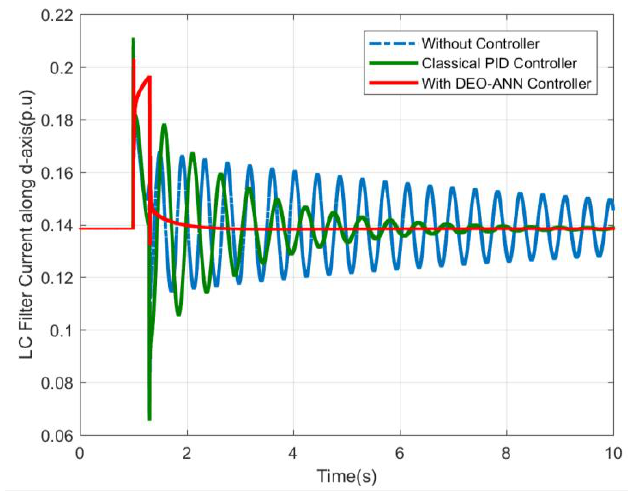
Figure 20. LC filter output current along the d-axis.